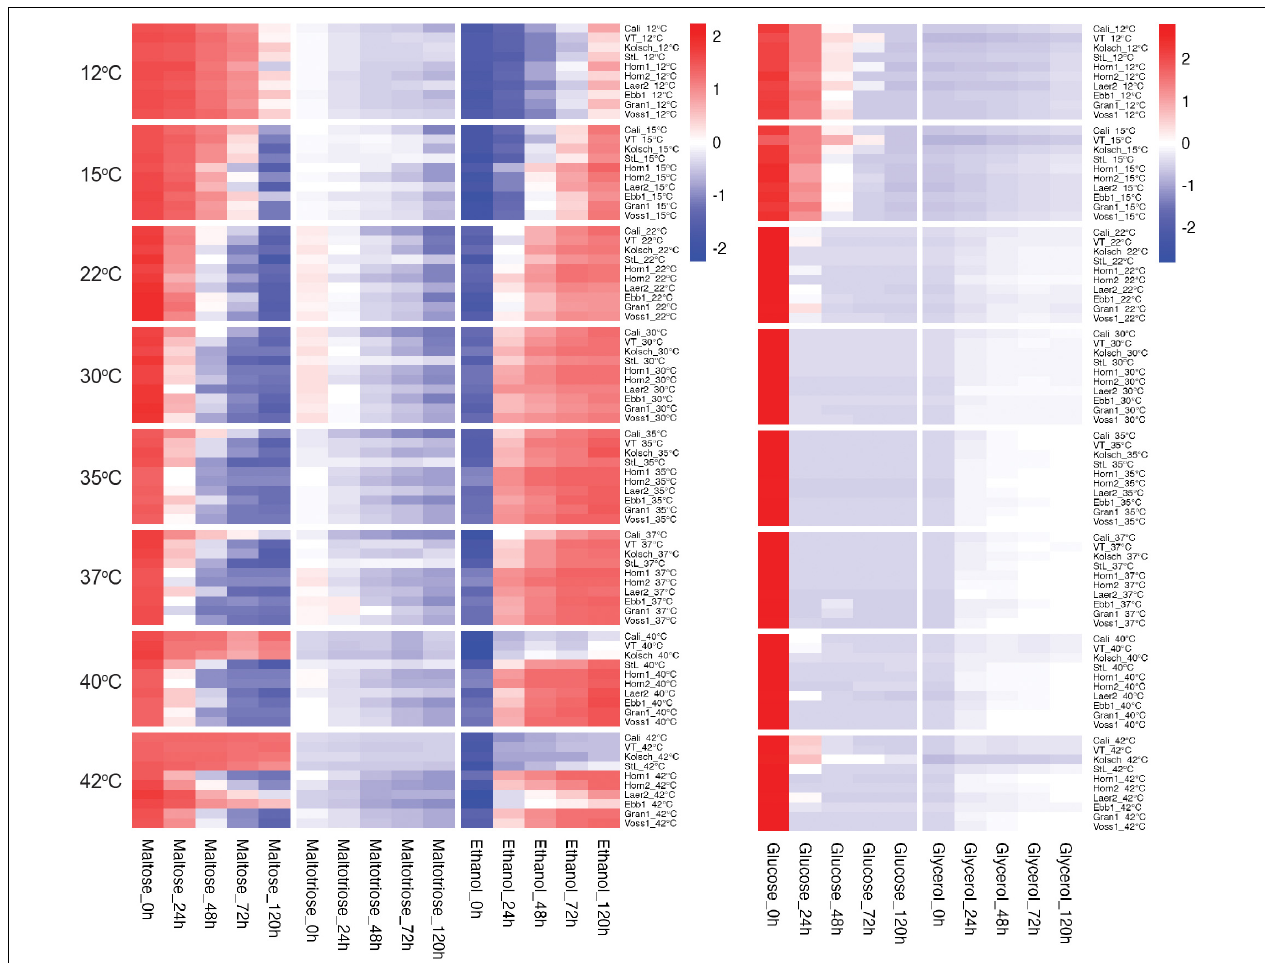
FIGURE 4 | Heatmap of wort sugar consumption and metabolite production of six Norwegian kveik strains and four commercial Saccharomyces cerevisiae beer strains during fermentations at a range of temperatures. Samples were collected at the given timepoints and the concentrations of all compounds were determined by HPLC as described in Methods. Data points represent the log1p transformed mean concentrations of biological replicates ( n =